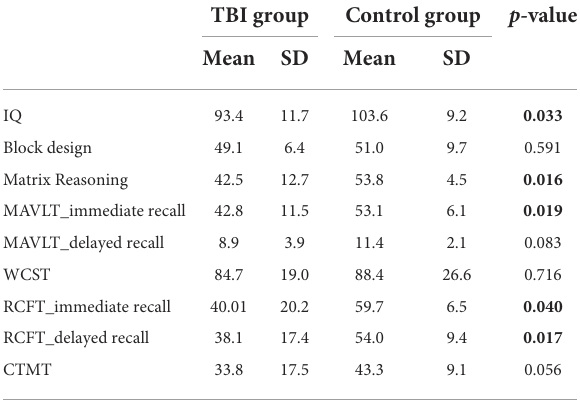
MAVLT, malay-version of auditory verbal learning test; WCST, wisconsin card sorting test; RCFT, rey complex figure test; CTMT, comprehensive trail making test. Significant